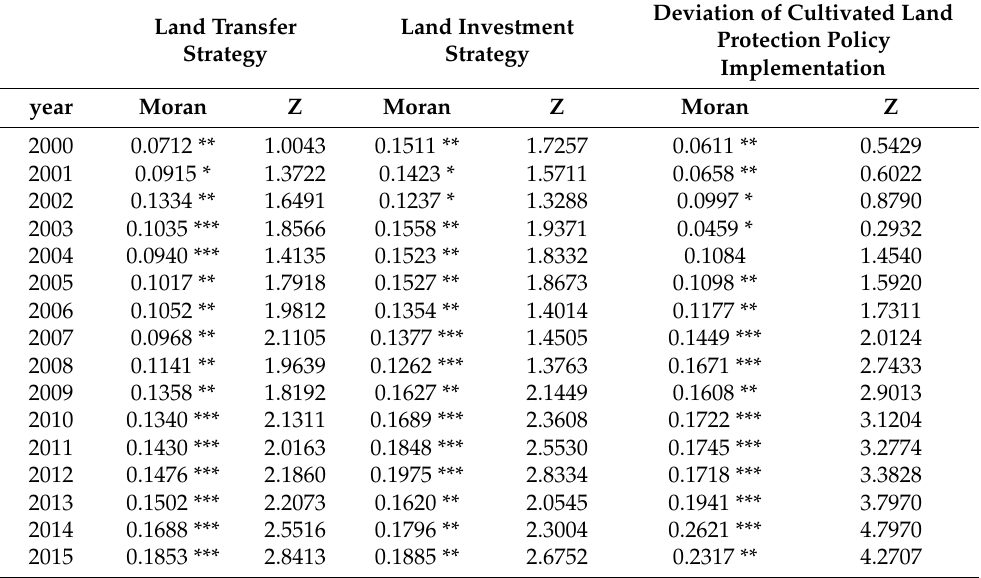
Table 1. Moran index table of the deviation between land fiscal strategy and the implementation of cultivated land protection policy from 2000 to